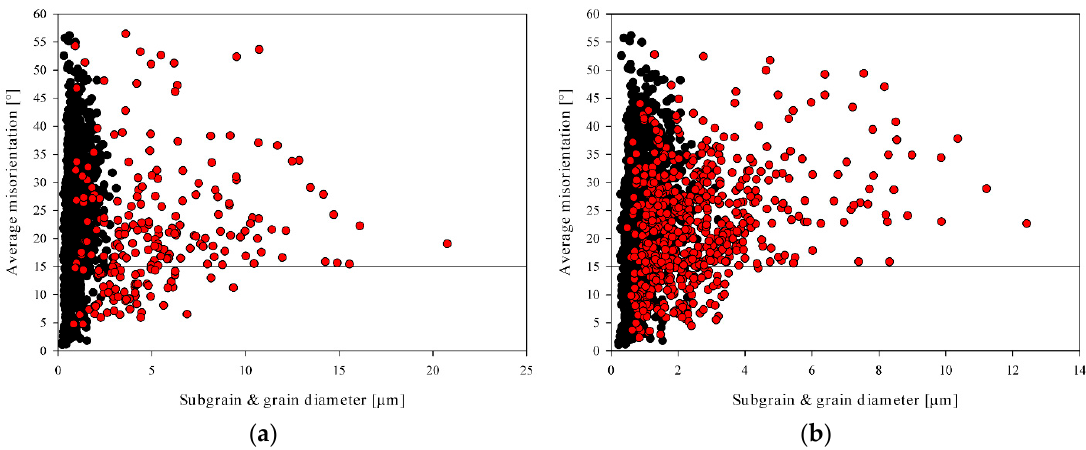
Figure 13. Average misorientation of individual grains plotted against mean equivalent circle diameter, d, for Cube (red)-oriented subgrains and grains after 10 5 s annealing at 220 °C. Black dots refer to as-deformed state. ( a ) “Large subgrain size” case; d = 5.25 µm. ( b ) “Small subgrain size” case; d = 2.62 µm.